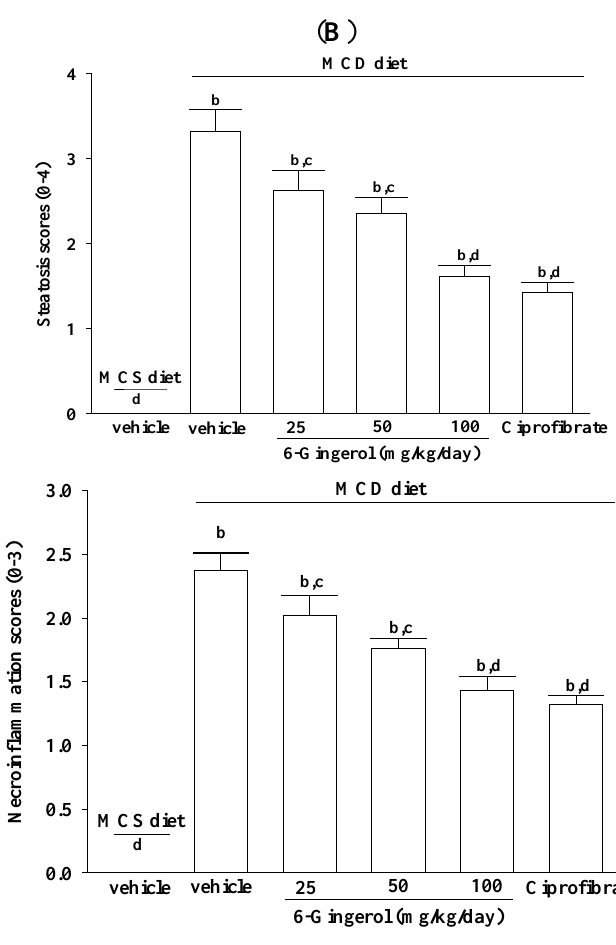
Figure 4. Effects of different treatments on liver histology. ( A ) Representative images of hematoxylin and eosin stained livers from MCS diet- and MCD diet-fed mice after four-weeks of 6-gingerol or ciprofibrate treatment. The vehicle (distilled water) used to prepare the test medication solutions was given at the same volume. Photomicrographs (original magnification, 200×) of tissues isolated from vehicle-treated MCS diet-fed mice (MCS + vehicle), vehicle-treated MCD diet-fed mice (MCD + vehicle), 25 mg/kg/day (MCD + 6-gingerol 25), 50 mg/kg/day (MCD + 6-gingerol 50), and 100 mg/kg/day (MCD + 6-gingerol 100) 6-gingerol-treated MCD diet-fed mice. Another group of MCD diet-fed mice was orally administered 10 mg/kg/day of ciprofibrate (MCD + ciprofibrate). Arrows and arrowheads indicate fat droplets and necro-inflammatory foci, respectively. ( B ) Hepatic steatosis and necro-inflammation scores. Results are means ± SD for eight mice/group after four weeks of treatment. a p < 0.05 and b p < 0.01 compared to the values of vehicle-treated MCS-diet fed mice. c p < 0.05 and d p < 0.01 compared to the values of vehicle-treated MCD-diet fed